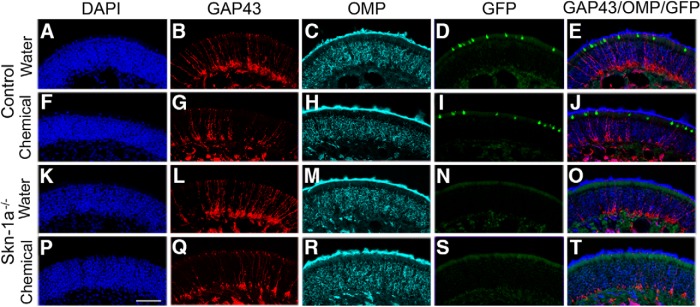
Immunohistochemical examination of the posterior MOE in control and Skn-1a-/- mice after 2-wk exposure. Posterior MOE sections at approximately the same region where EOG was recorded were obtained from control and Skn-1a-/- mice exposed to either water or chemicals for 2 wks. The sections were immunoreacted with antibodies against GAP43 and OMP and stained with DAPI. Confocal images were taken from olfactory turbinate II. A–E, Control, water-exposed. F–J, Control, chemical-exposed. K–O, Skn-1a-/- mouse, water-exposed. P–T, Skn-1a-/- mouse, chemical-exposed. DAPI staining (blue; A, F, K, P); GAP43 immunoreactivity (red; B, G, L, Q); OMP immunoreactivity (cyan; C, H, M, R); GFP-positive TRPM5-MCs (green; D and I only, control mice); overlay of GAP 43, OMP, and GFP (E, J, O, T). Similar morphology and marker expression were found in four groups of mice, indicating there was no obvious tissue damage in both control and Skn-1a-/- mice after chemical exposure in the posterior MOE regions where EOG recordings were performed. Scale bar: 50 µm.